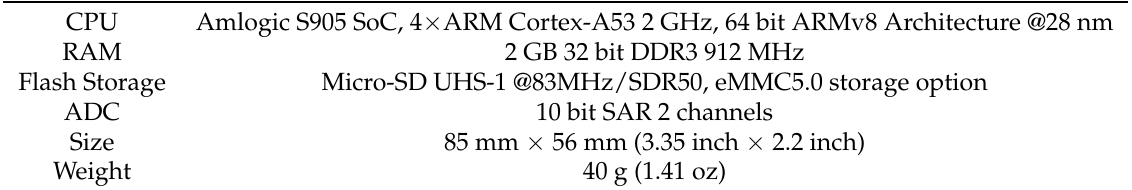
Table 1. ODROID-C2 Specifications from